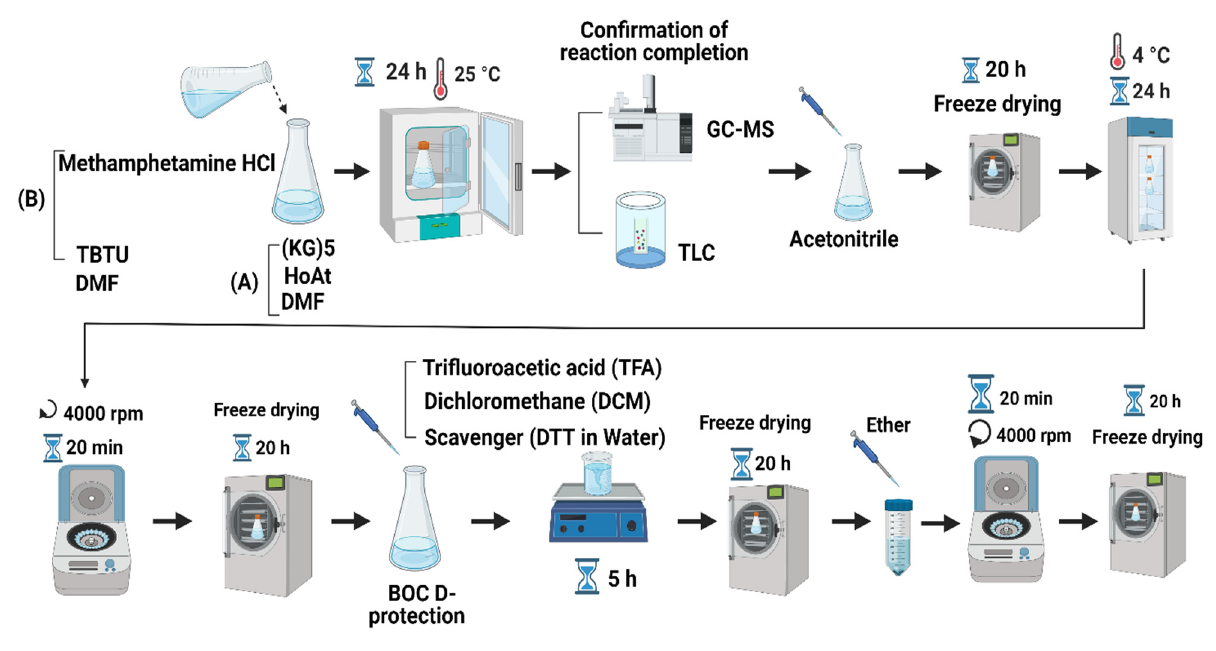
Figure 1. Summary of METH hapten synthesis protocol (figure created with